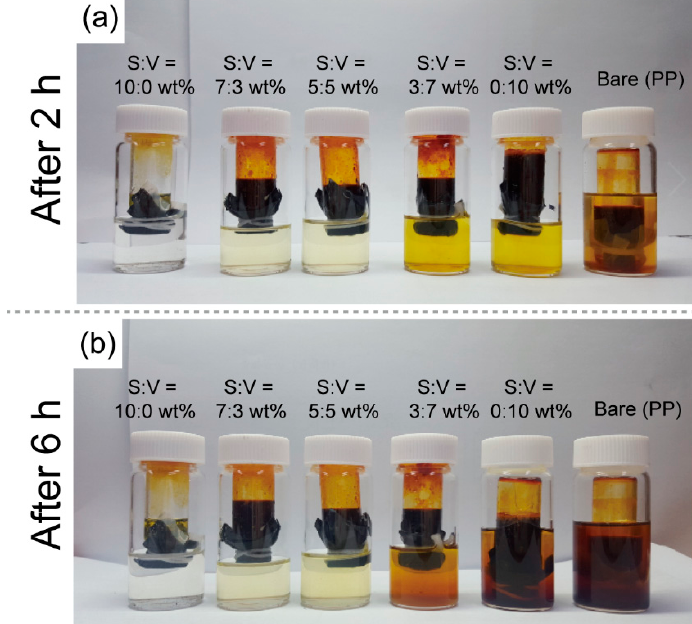
Figure 2. Digital camera images of polysulfide diffusion experiments after ( a ) 2 h and ( b ) 6 h. The inner glass tube filled with a mixture of polysulfide (Li 2 S 6 ) and control electrolyte (DME/DOL, 1:1 by vol.) was wrapped with various types of separators, while the outer glass tube was filled with control electrolyte. S:V indicates the weight ratio of Super-P to VGCF.